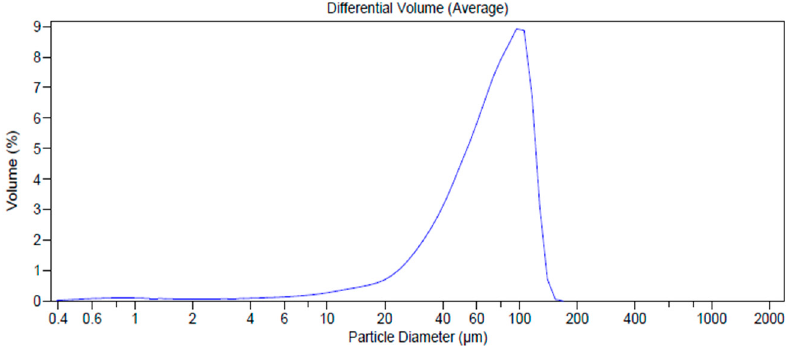
Figure 9. Dimensional distribution analysis (by Laser Light Scattering (LLS)) of AJEP 3 after six months